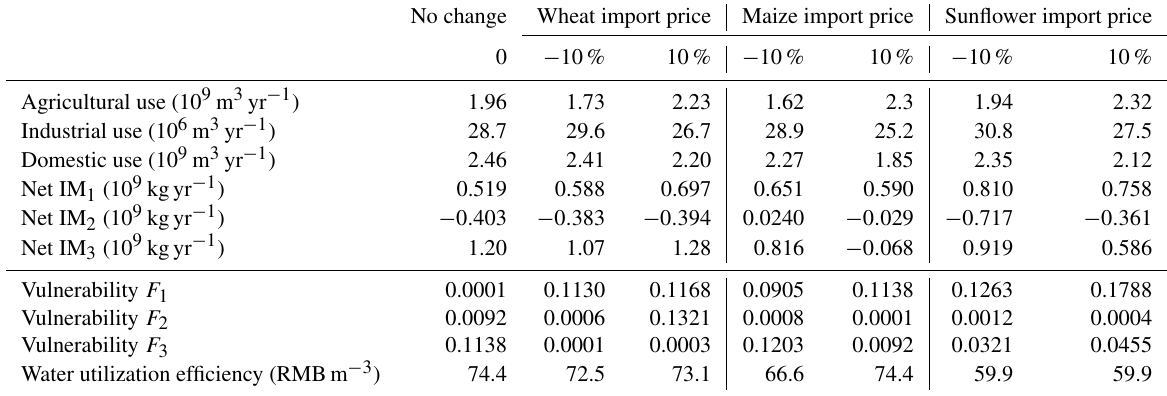
No change Wheat import